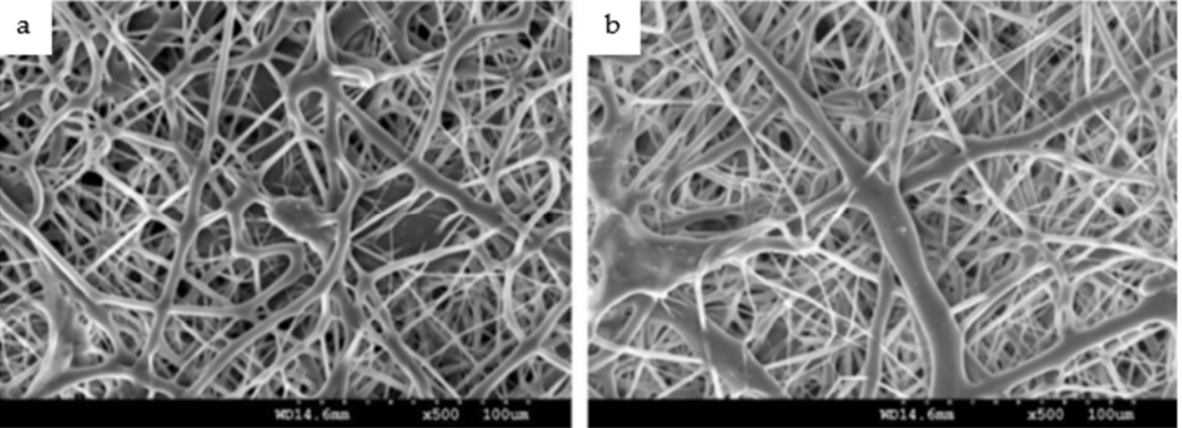
Figure 3. SEM images of human fetal osteoblastic cell lines seeded on Ti substrates coated with PCL/TiO 2 NFs after incubation for ( a ) 1 day and ( b ) 3 days [1].